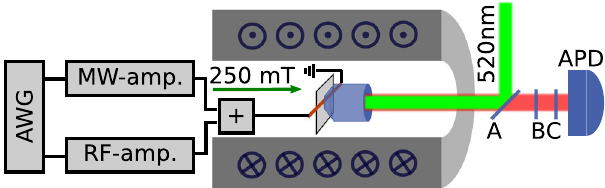
Fig. 6 Single NV-center confocal setup with microwave control. The diamond with individual NV-centers is studied with a confocal microscope in the center of a room temperature bore of a superconducting magnet, operated at 250 mT. For excitation, a 520 nm diode laser is used, the beam is re fl ected from a wedged mirror (A) and coupled into the objective. The fl uorescence of the NV is passing again through the wedged mirror (A), through a pinhole 50 μ m, (B) and fi nally through a long-pass fi lter, 650 nm, (C) before getting detected with an avalanche photon detector (APD) (Perkin – Elmer SPCM). The microwave and radio frequencies are generated on a two-channel arbitrary waveform generator, sent to ampli fi ers, and combined before the microwave structure, where the diamond is glued